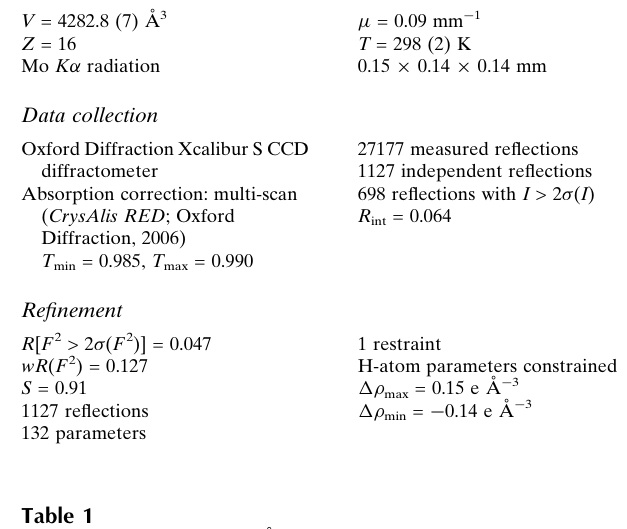
Hydrogen-bond geometry (A˚ , (cid:4)